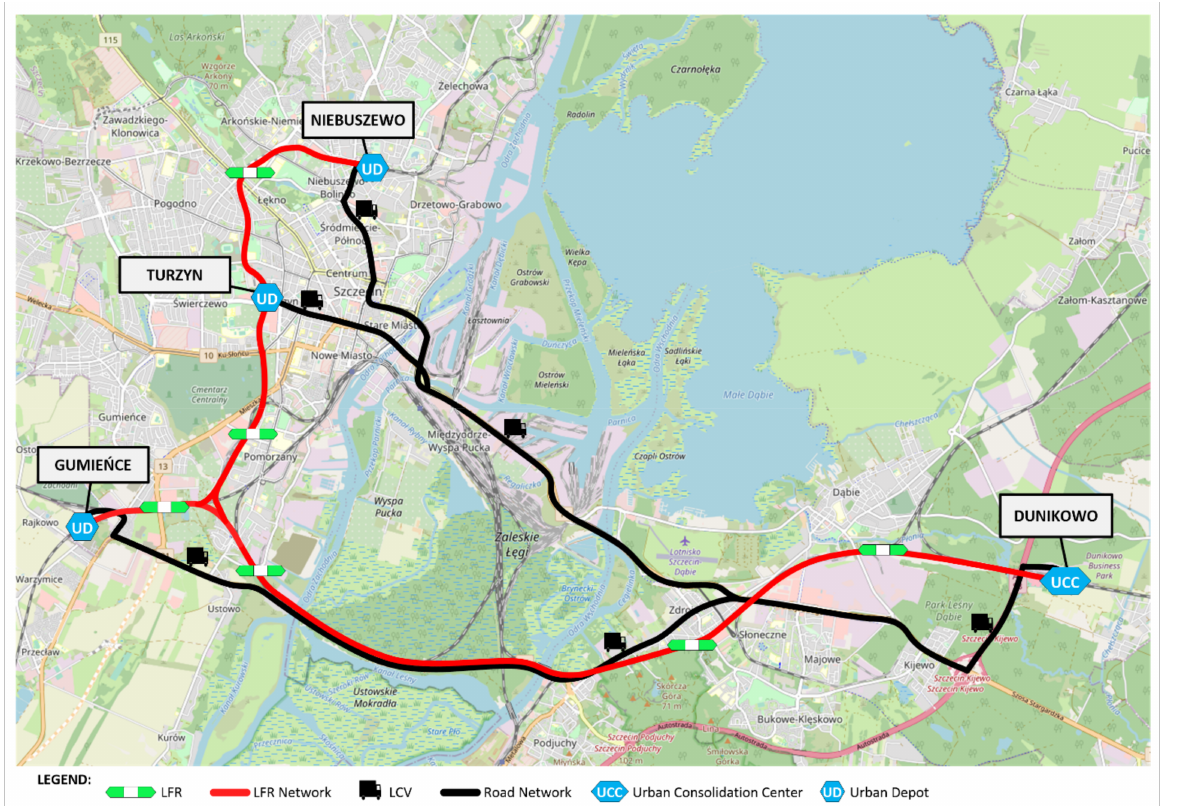
Figure 4. Routes that are part of variant V0 and variant